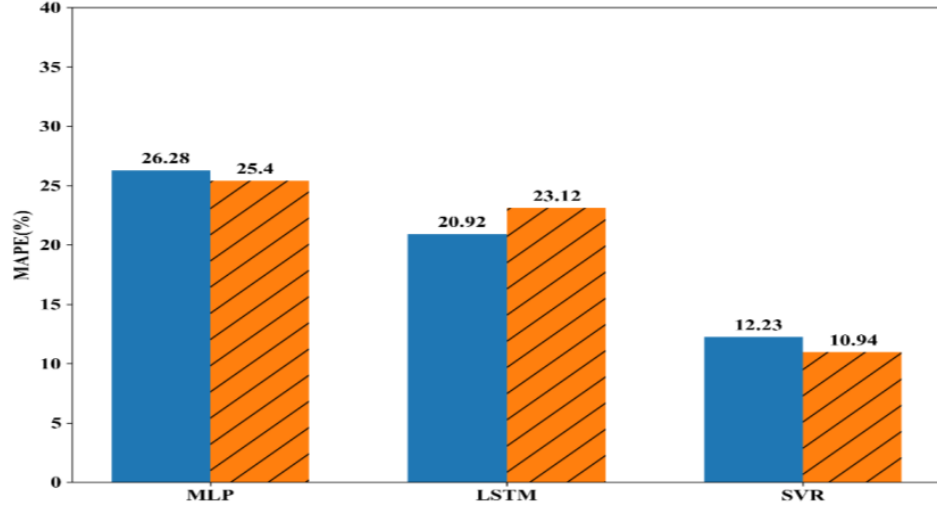
Figure 6. Experiment result for battery #1.